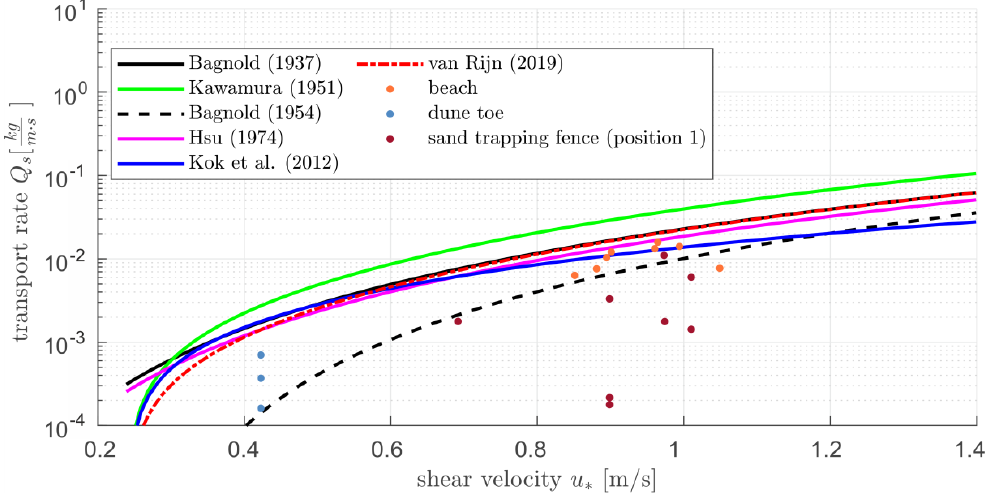
Figure 11. Comparison between the measured sediment transport rates on Langeoog and the predicted sediment transport rates for five di ff erent transport